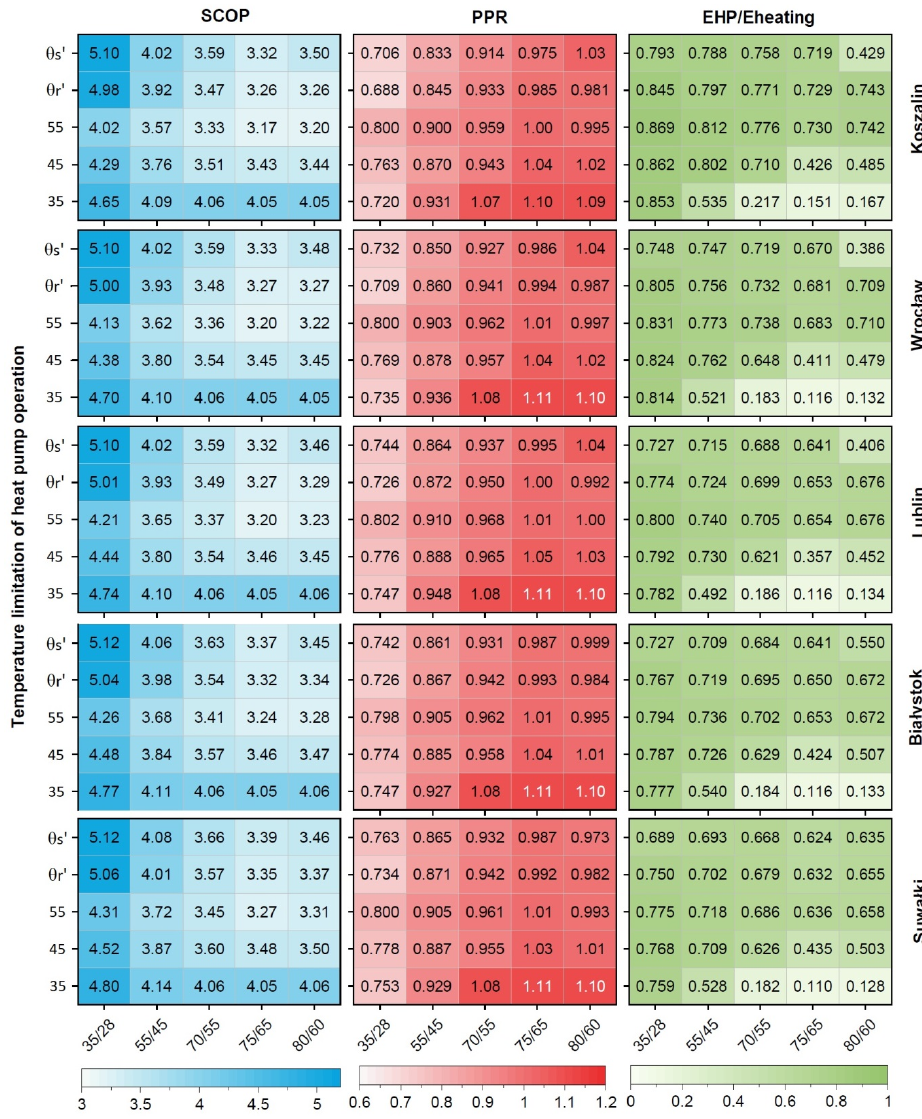
Figure 5. Results of the simulations.